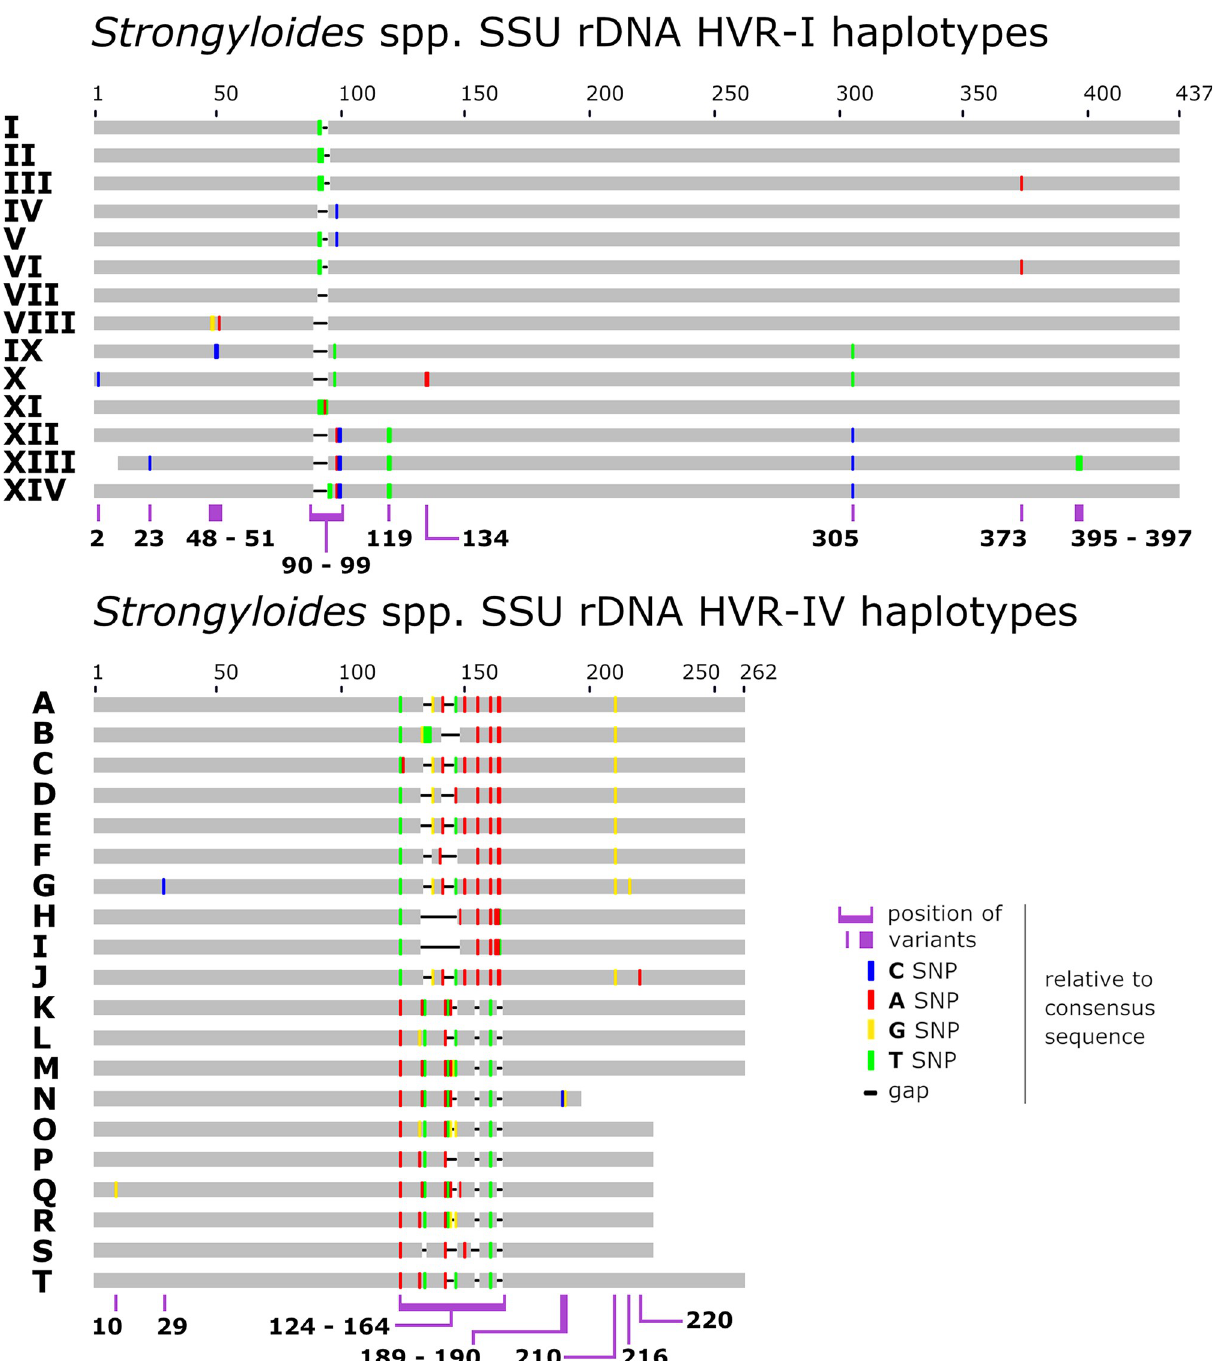
Fig 1. Schematic of the Strongyloides spp. genotyping scheme. A graphical representation of the Strongyloides spp. genotyping scheme described previously [21], expanded to include additional genotypes from S . stercoralis and S . fuelleborni . This scheme includes novel sequences identified by Barratt et al., and 18S sequences that were available in GenBank (GB), where the appropriate 18S HVR-I and/or HVR-IV regions were captured. Sequences from GB possessing Ns or ambiguous bases were excluded from the scheme. For additional details on the hosts in which these Strongyloides spp. haplotypes were detected refer to the Tables in Barratt et